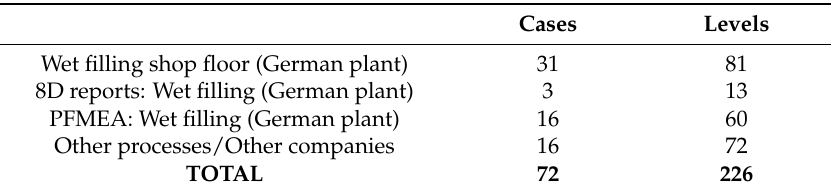
Table 1. Case base of prototype